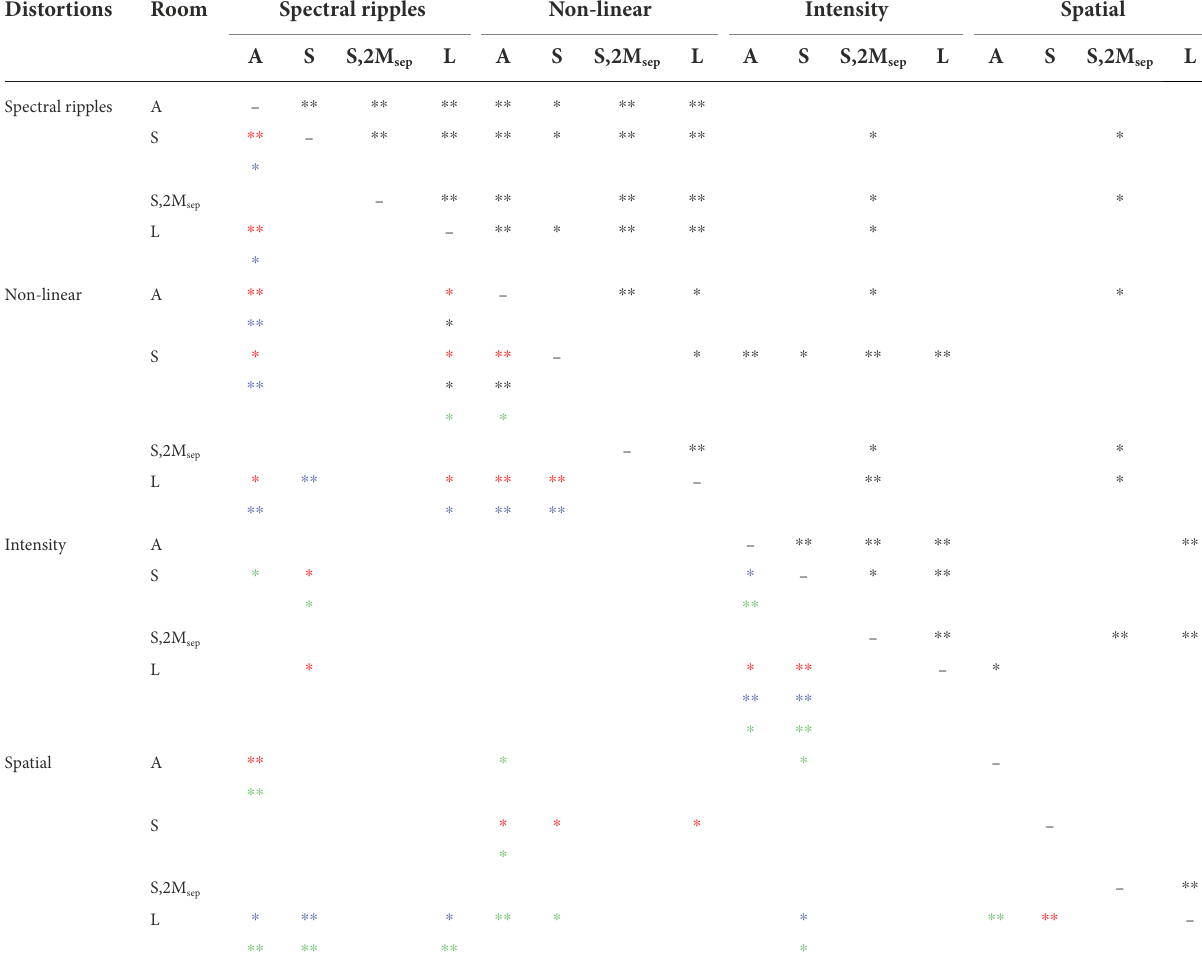
TABLE 4 Statistically significant correlations for the detection and discrimination thresholds are represented as black asterisks in the upper right segment. Distortions Room Spectral ripples Non-linear Intensity Spatial